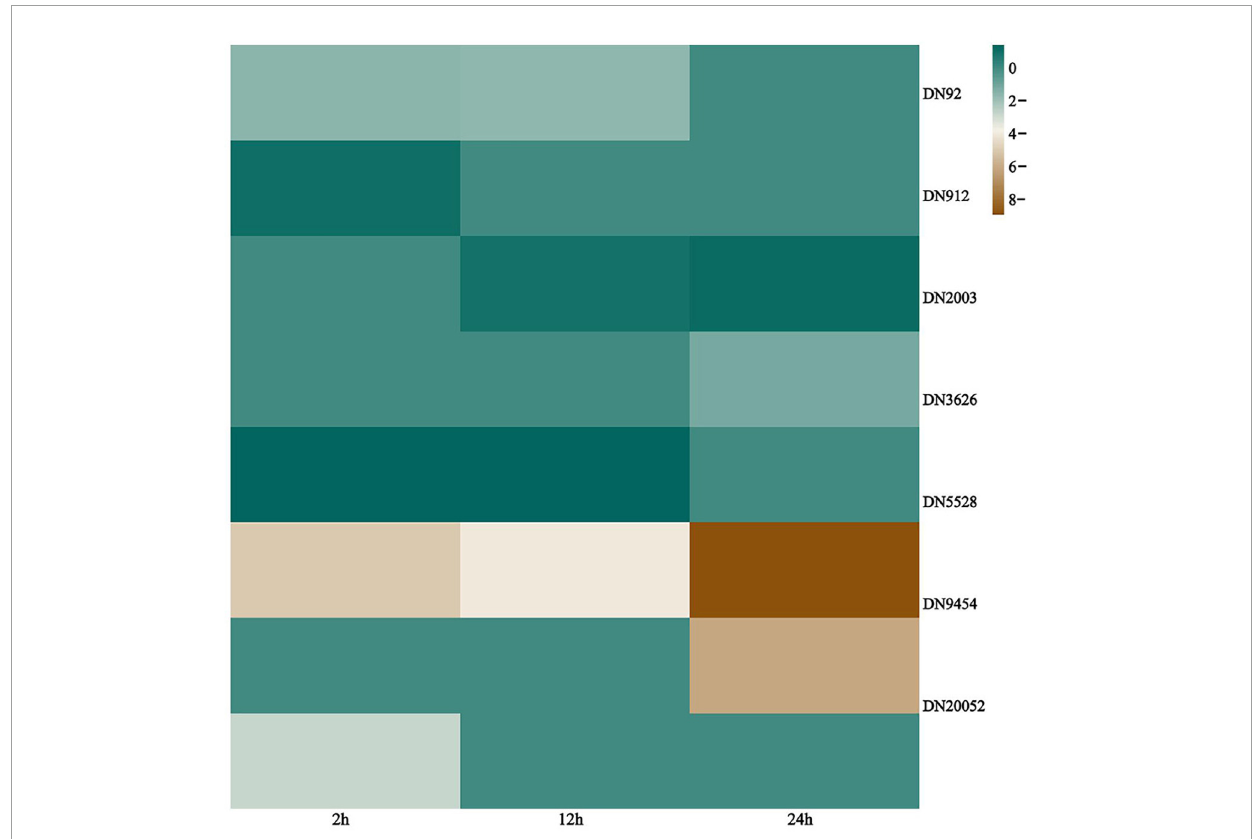
FIGURE6 Heatmaps of differentially expressed genes (DEGs) involved in sphingolipid metabolism pathways. The log 2Foldchange was colored using Genescloud tools (green for up-regulated, brown for down-regulated).